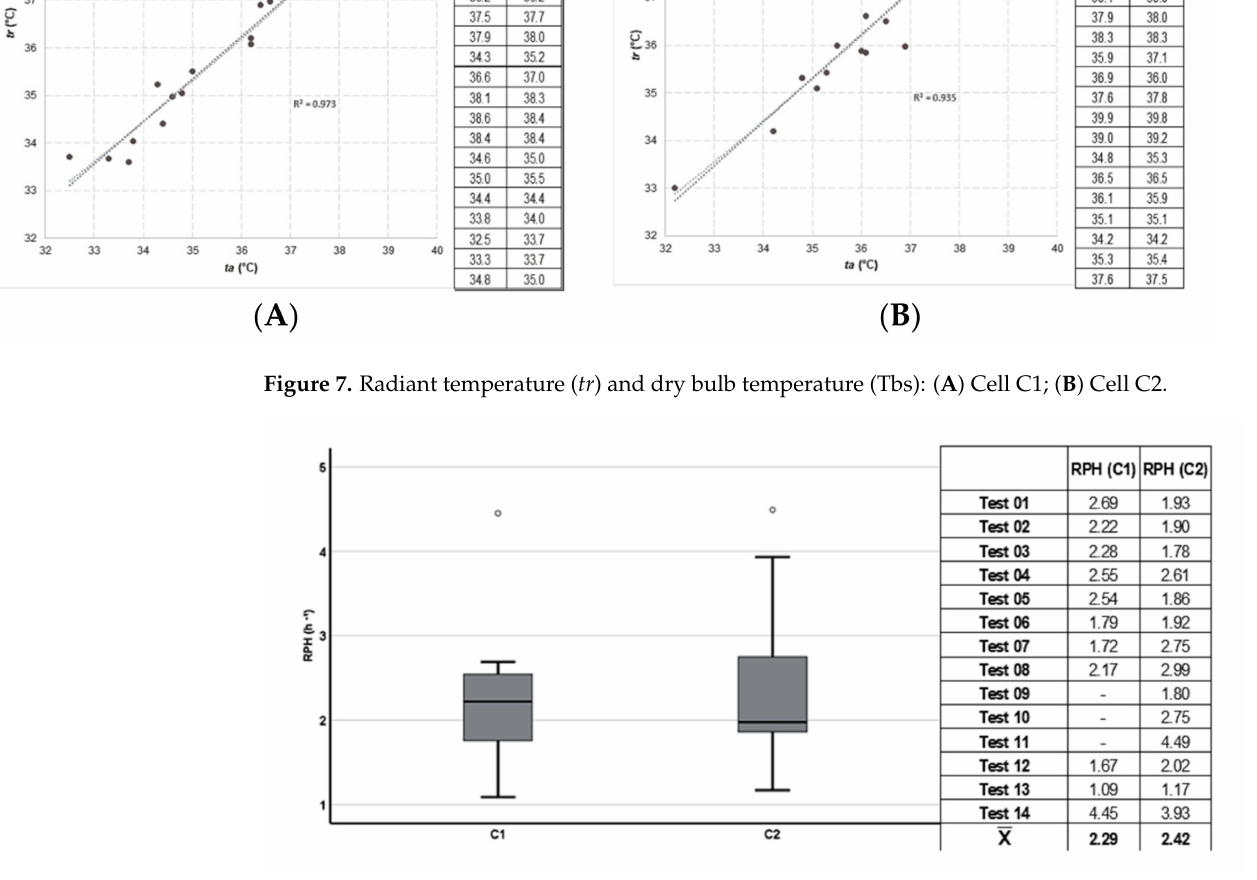
Figure 8. Air change rate per hour (RPH) in cells C1 and